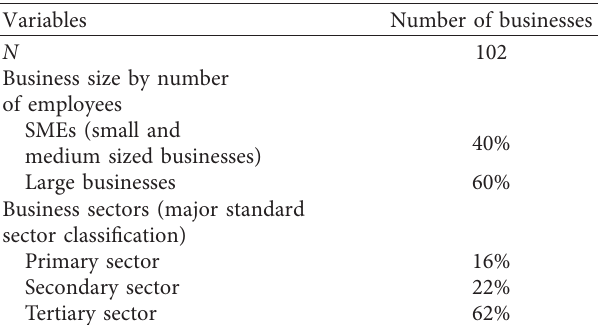
Table 1: Characteristics of the